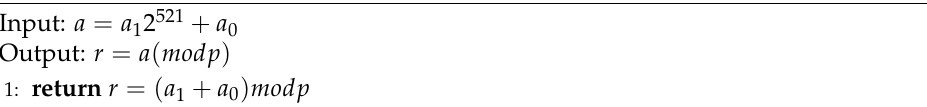
Algorithm 7 Fast Modular Reduction for NIST